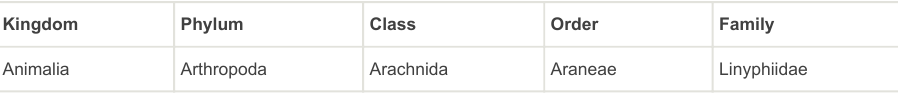
Figure(s) or Photo(s): Fig.